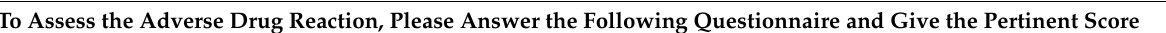
Table 1. Naranjo adverse drug reaction (ADR) probability scale. ADR Probability